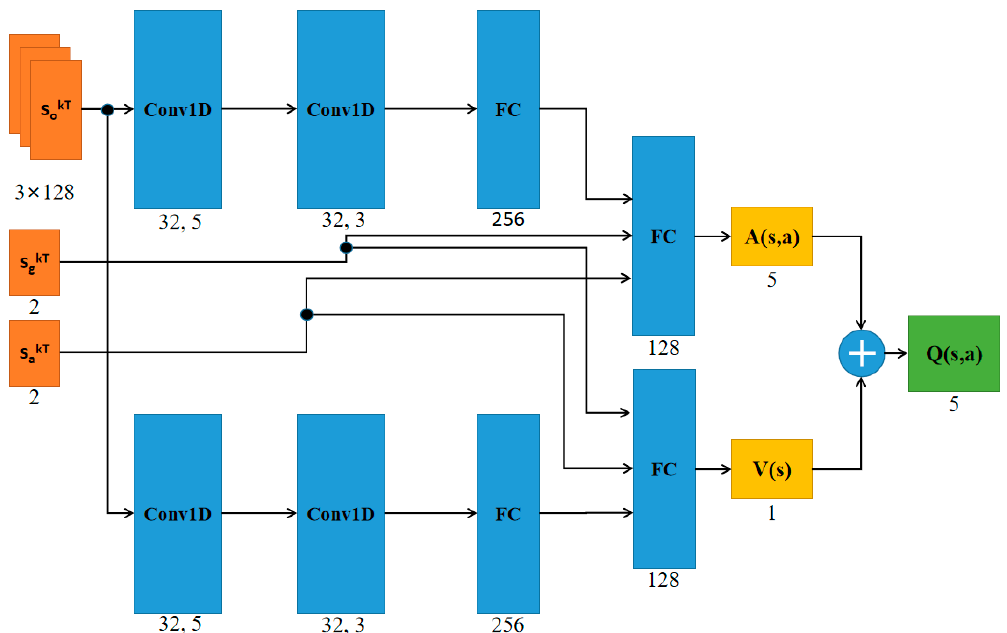
Figure 3. The structure diagram of the neural network. s okT , s gkT , and s akT were used as the input of the network structure, and the output of the network structure was the Q value of five actions. ReLU [32] was used as the non-linear activation function. Conv1D, convolutional neural network; FC, fully connected neural network.